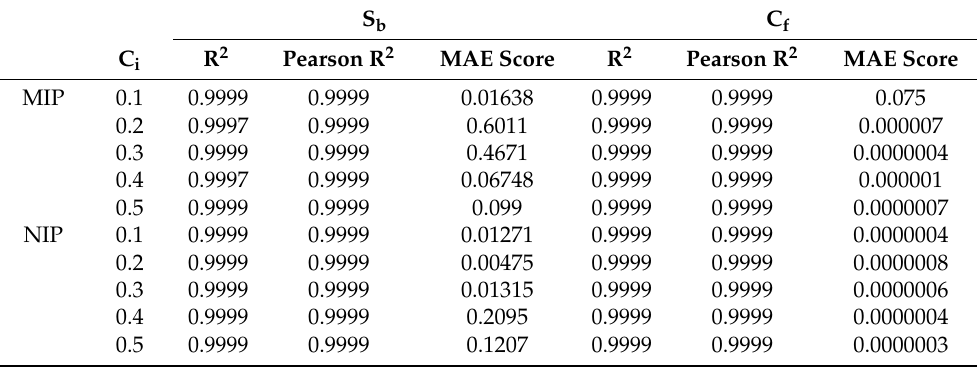
Table 9. Analysis of the error and correlation of the trained datasets at a given C i value for the graph ChemCeption model with SMILESToImage featurizer.